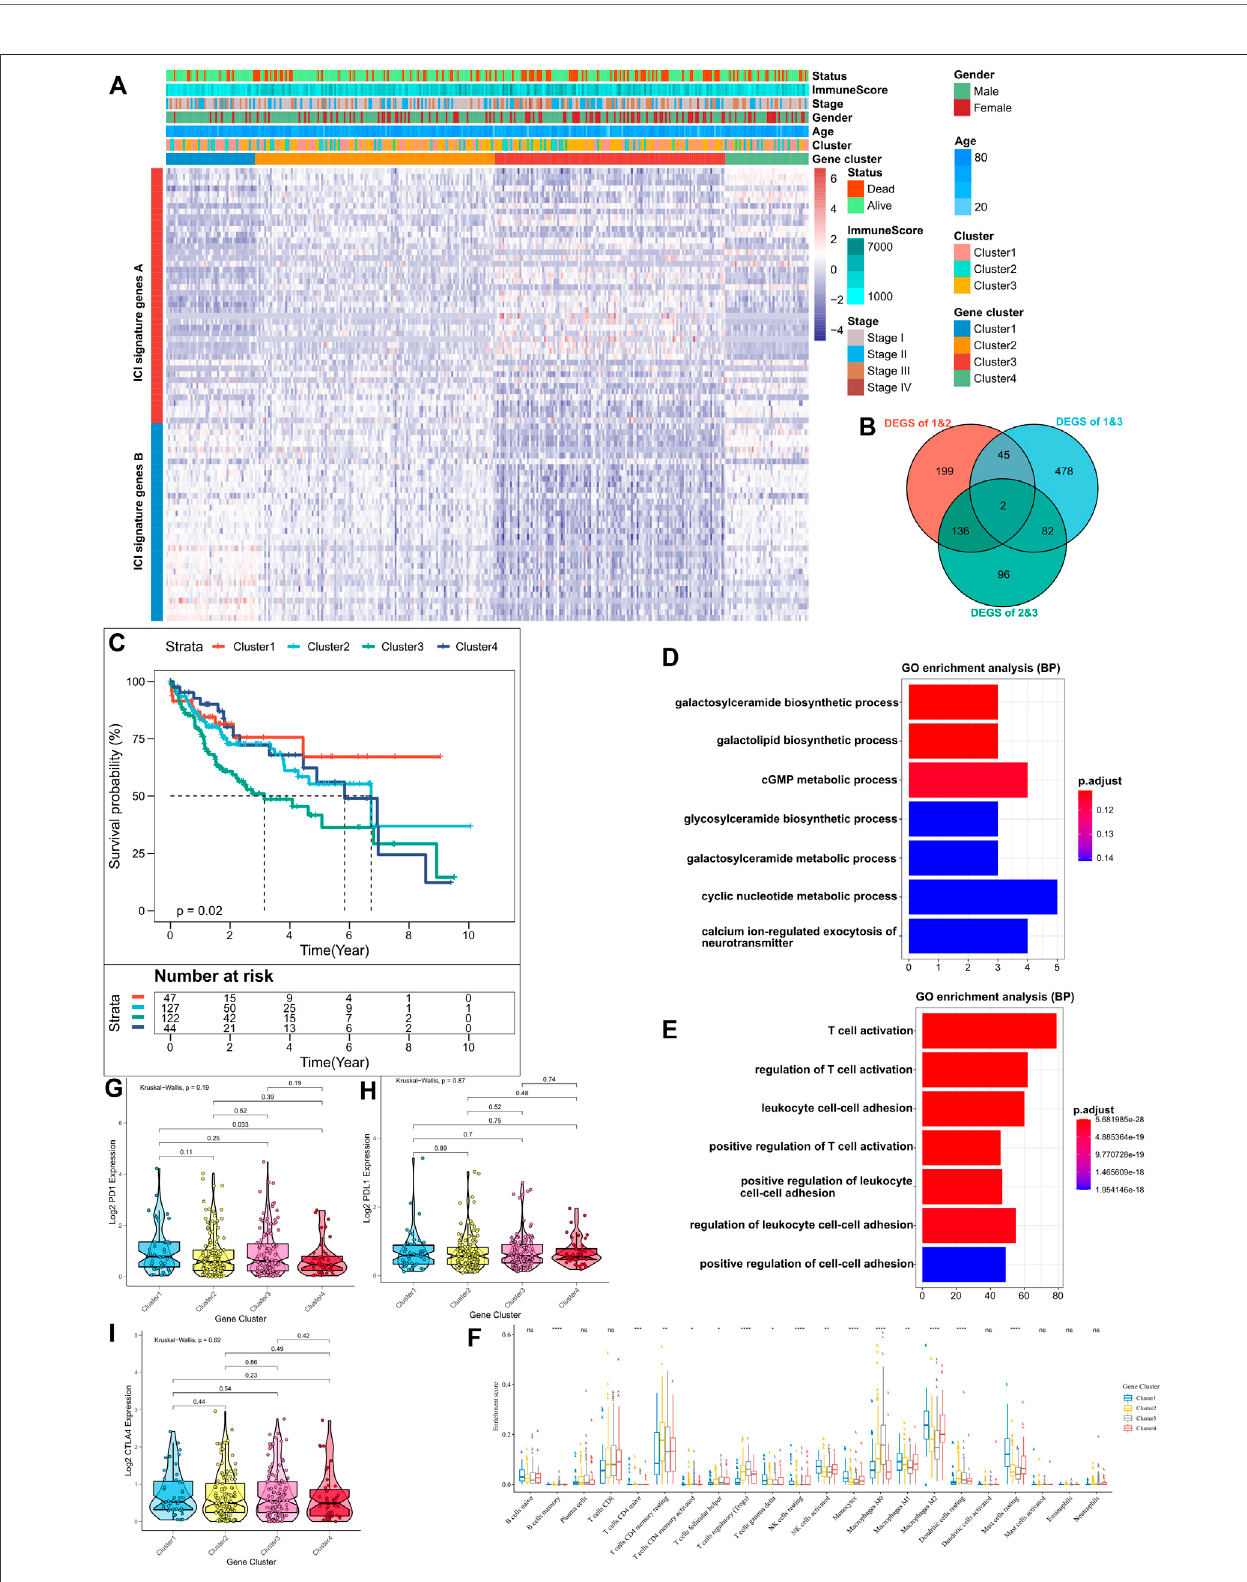
FIGURE 2 | Identi fi cation of Immune-Related Gene Subtypes. (A) Unsupervised clustering of common DEGs in the three ICI subgroups, dividing patients into four groups; (B) NumberofDEGsamongsubgroupsasshownbyVenndiagram; (C) Kaplan-Meiercurvesforthethreesubgroupsofpatients,wherethelog-ranktestshows